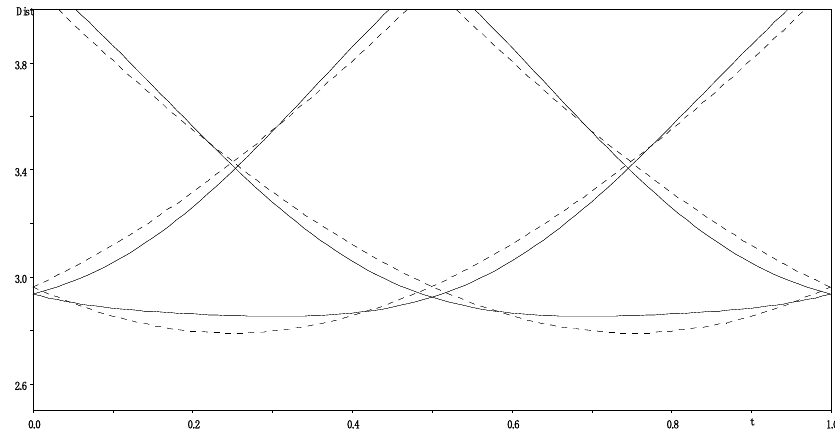
Figure 4. Caption: Distances Ru2 (second sub cell)—Y1 (first sub cell) as a function of position in internal space. Solid lines represent the modulated structure, while dashed lines show distances in a rigid, unmodulated composite structure. Note the tendency towards a more homogeneous surrounding for Ru2 as a result of even very slight modulation. For reasons of symmetry, each line represents three interatomic distances, so that the graph shows variation in coordination number for Ru2 between three and six, if a bonding cut-off is set at 3.2 Å The overall composition of the single crystal is Y 3 Ru 1.79 as defined by the unit cell and the q- vector. The content of the first sub cell is Y 18 Ru 6, while that of the second subcell is Ru 3 . Since the ratio between the sub cell volumes is given by the ratio of the c -axes, and the second sub cell hence is 1.572 times smaller (and consequently denser), the combined cell content is given by Y 18 Ru 6 + 1.572* Ru 3 = Y 18 Ru 10.72 . The difference in electronegativity between Y and Ru is close to unity and the compound must be considered to be polar, albeit not strongly so.